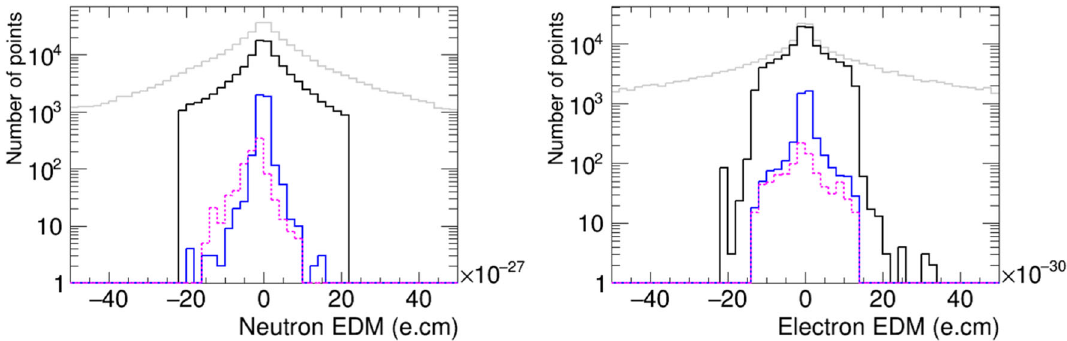
Fig. 7 Distributions of the neutron EDM (left) and the electron EDM (right), showing the effects of taking into account the LHC constraints onsparticlemassesandimposingtheEDMconstraints.Greyhistogram: all points passing the LHC mass and flavour constraints; black: also